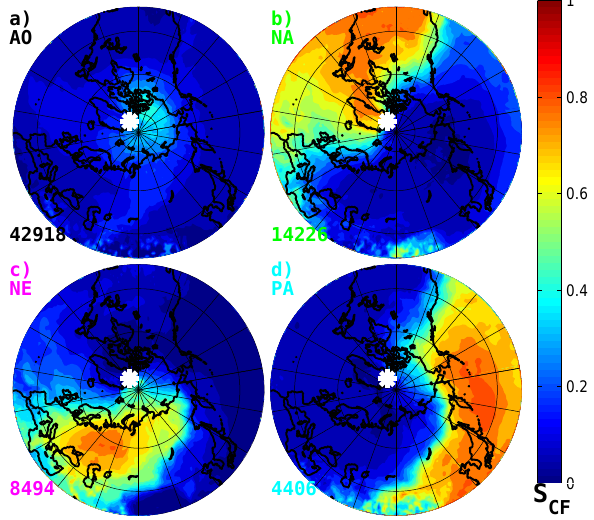
Fig. 8. Same as Fig. 7 for Barrow 1988–2008 (see Eq. 4). The location of the Barrow station is marked by a white asterisk.